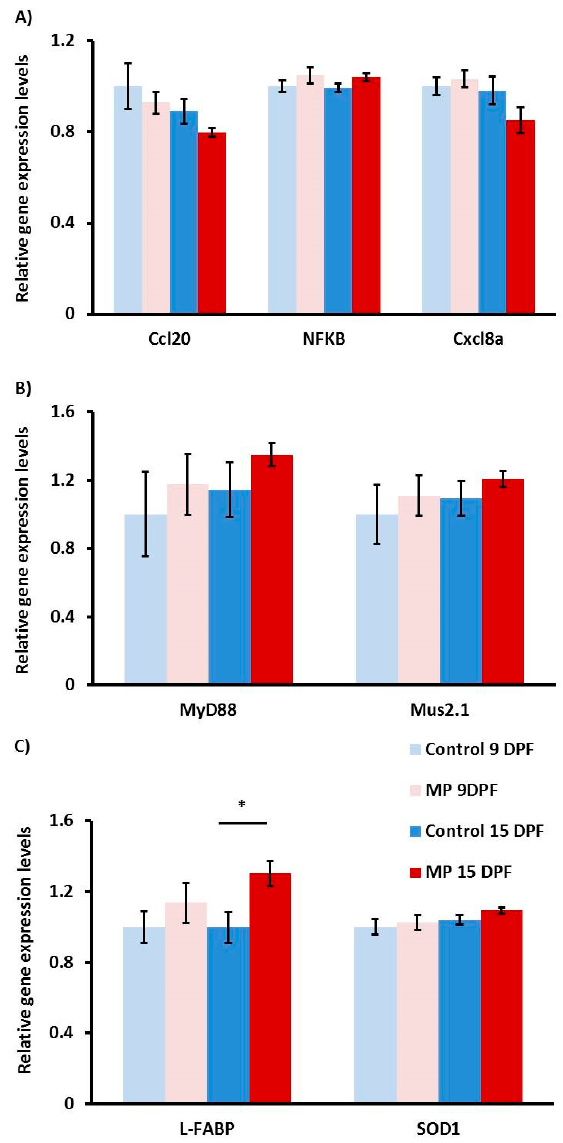
Figure 2. Gene expression in MP and control fish at 9 and 15 dpf. Gene expression analysis of inflammatory ( A ), microbial ( B ), and oxidative stress ( C ) genes in fish exposed to MP for 4 (pink) and 10 days (red) or aged matched control fish (light and dark blue). EF1 α / RLP-13a were used as housekeeping genes. Statistically significant di ff erences are indicated with an asterisk ( n = 9, p <